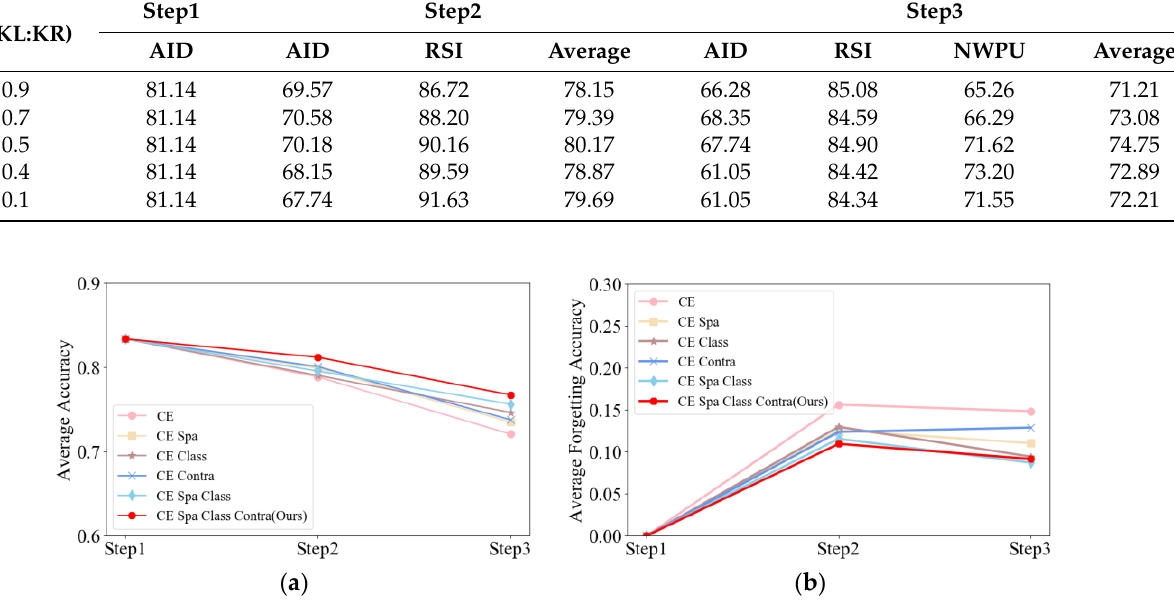
Figure 6. Average task accuracy curve ( a ) and average task forgetting accuracy curve ( b ) for different combinations of loss function on three-step continual learning tasks.